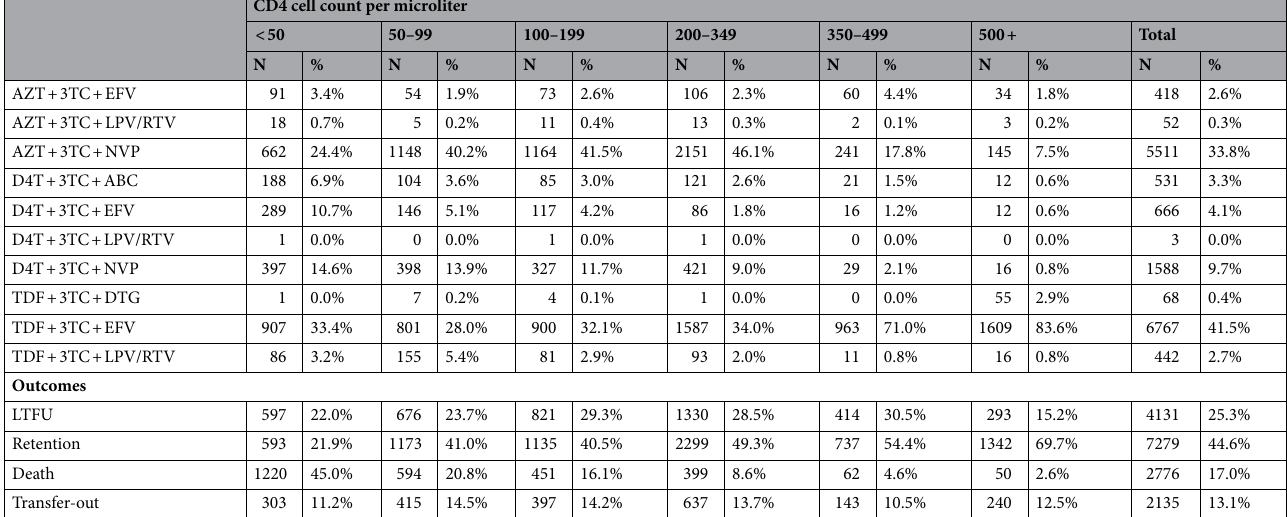
Table 3. Characteristics of HIV patients enrolled at Carmelo Hospital of Chókwè between January 1, 2002 and December 31, 2019 by CD4 Cells count status. ART antiretroviral treatment, ABC abacavir,